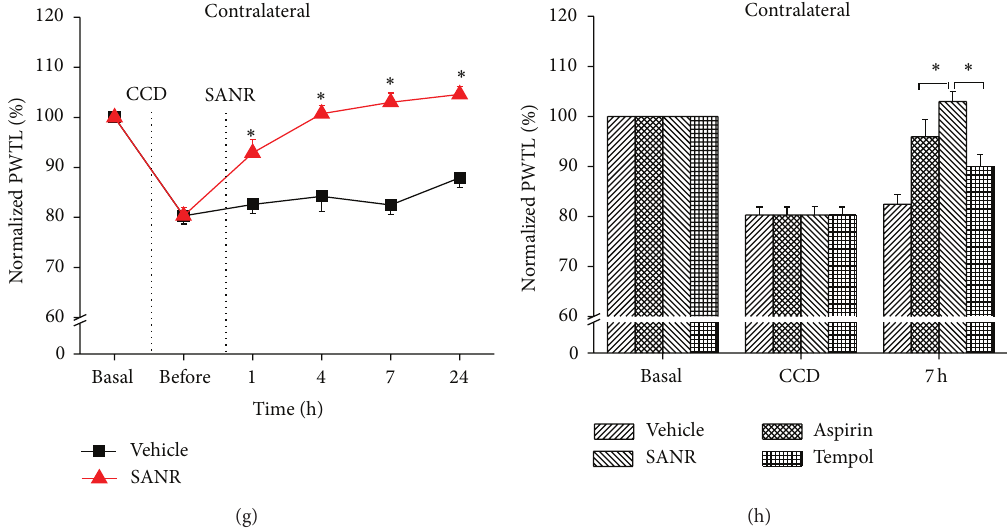
Figure 5: Acute treatment of SANR produces antinociceptive effect on CCD-induced mechanical hypersensitivity and thermal hyperalgesia in bilateral hindpaws, which is more potent than parent nitroxide moiety Tempol and parent NSAIDs moiety aspirin. (a, c) Time course of mechanical hypersensitivity (a) and thermal hyperalgesia (c) in ipsilateral hindpaw of CCD rats before and after i.p. SANR (180 𝜇 mol/kg) (red) and vehicle treatment (black). Note that ipsilateral mechanical and thermal hyperalgesia was attenuated significantly by SANR. (b, d) Comparison of analgesic potency in ipsilateral mechanical (b) and thermal hyperalgesia (d) produced by the same concentration of SANR, Tempol, and aspirin. Note that SANR showed significantly stronger effect than Tempol and aspirin. (e, g) Contralateral mechanical hypersensitivity (e) and thermal hyperalgesia (g) was reduced by acute SANR as well. (f, h) Comparison of the efficacy by SANR with Tempol and aspirin in inhibiting mechanical (f) and thermal hyperalgesia (h). All data are expressed as mean ± S.E.M. ∗ 𝑃 < 0.05